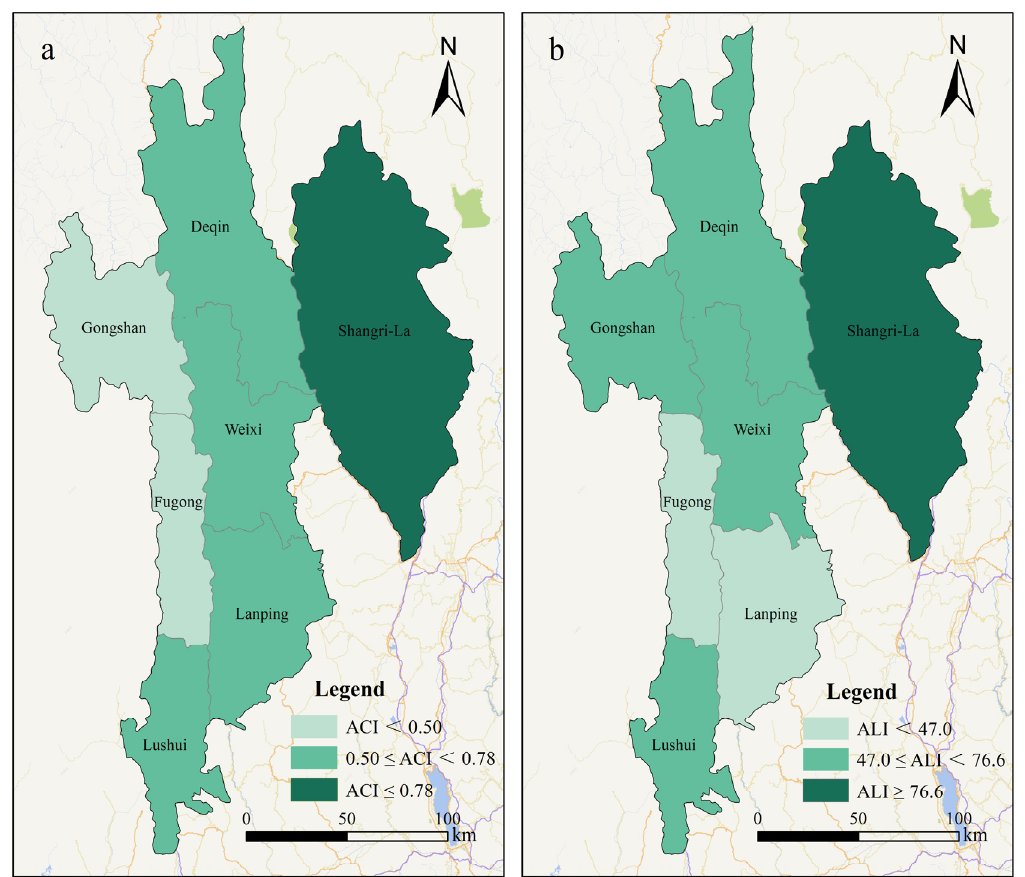
Figure 3. Spatial differentiation of ACI ( a ) and ALI ( b ).